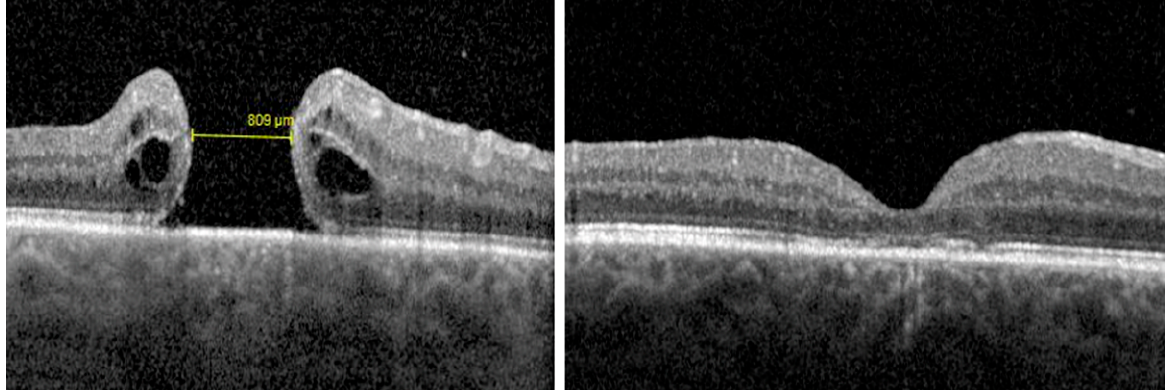
Figure 2. Case 2: A full-thickness refractory large macular hole (rFTMH) (minimum hole width 809 µ m) that did not close after a primary 25-G pars plana vitrectomy (PPV) with internal limiting membrane peeling ( left ). At 6 months after secondary PPV with autologous platelet-rich plasma and gas tamponade, complete closure of rFTMH is seen ( right ).